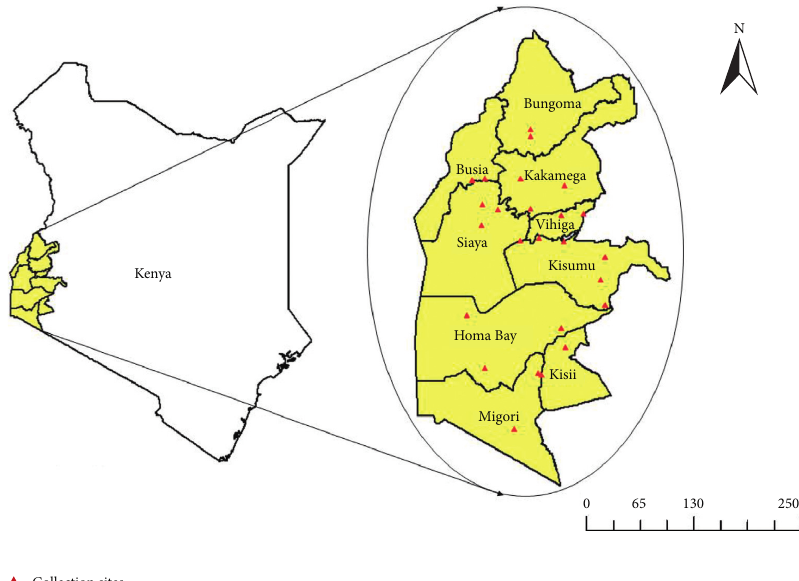
Figure 1: Map of Kenya showing the sampled counties and the collection